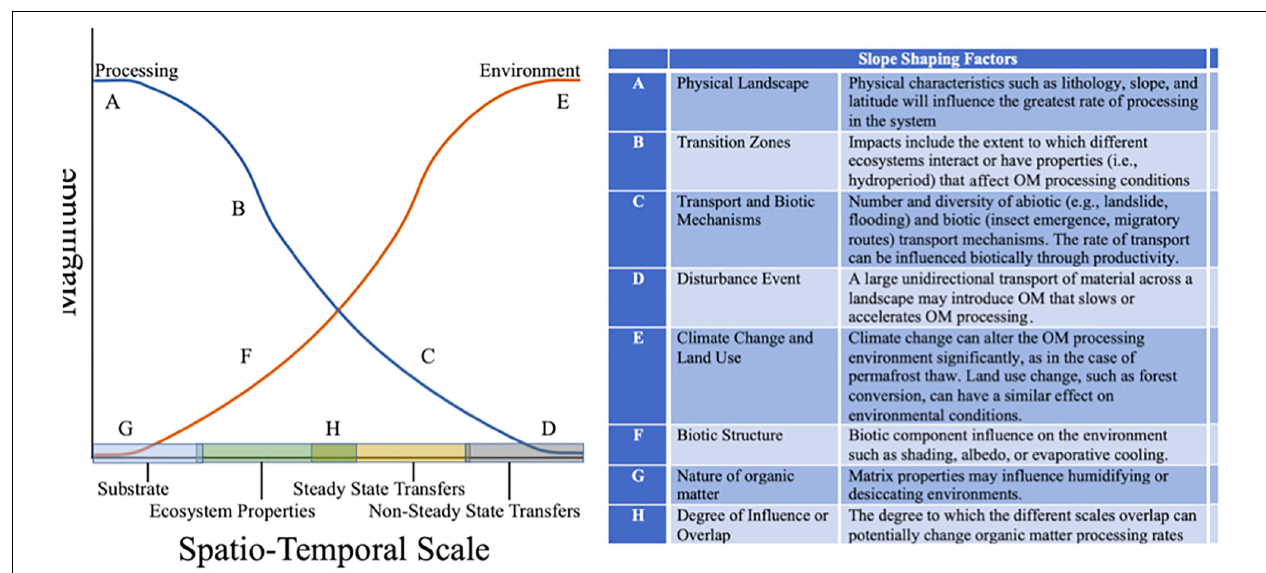
FIGURE 4 | Conceptual model of different spatio-temporal level impacts on potential OM processing and the environment in a hypothetical landscape. The responses are expected to shift for each landscape determined by the relative impact of the spatio-temporal levels listed along the x -axis. Examples of different impacts are provided in the accompanying table of slope shape forming factors. The spatio-temporal hierarchy forms the basis for the various colors represented in the histograms of Figures 1 , 2